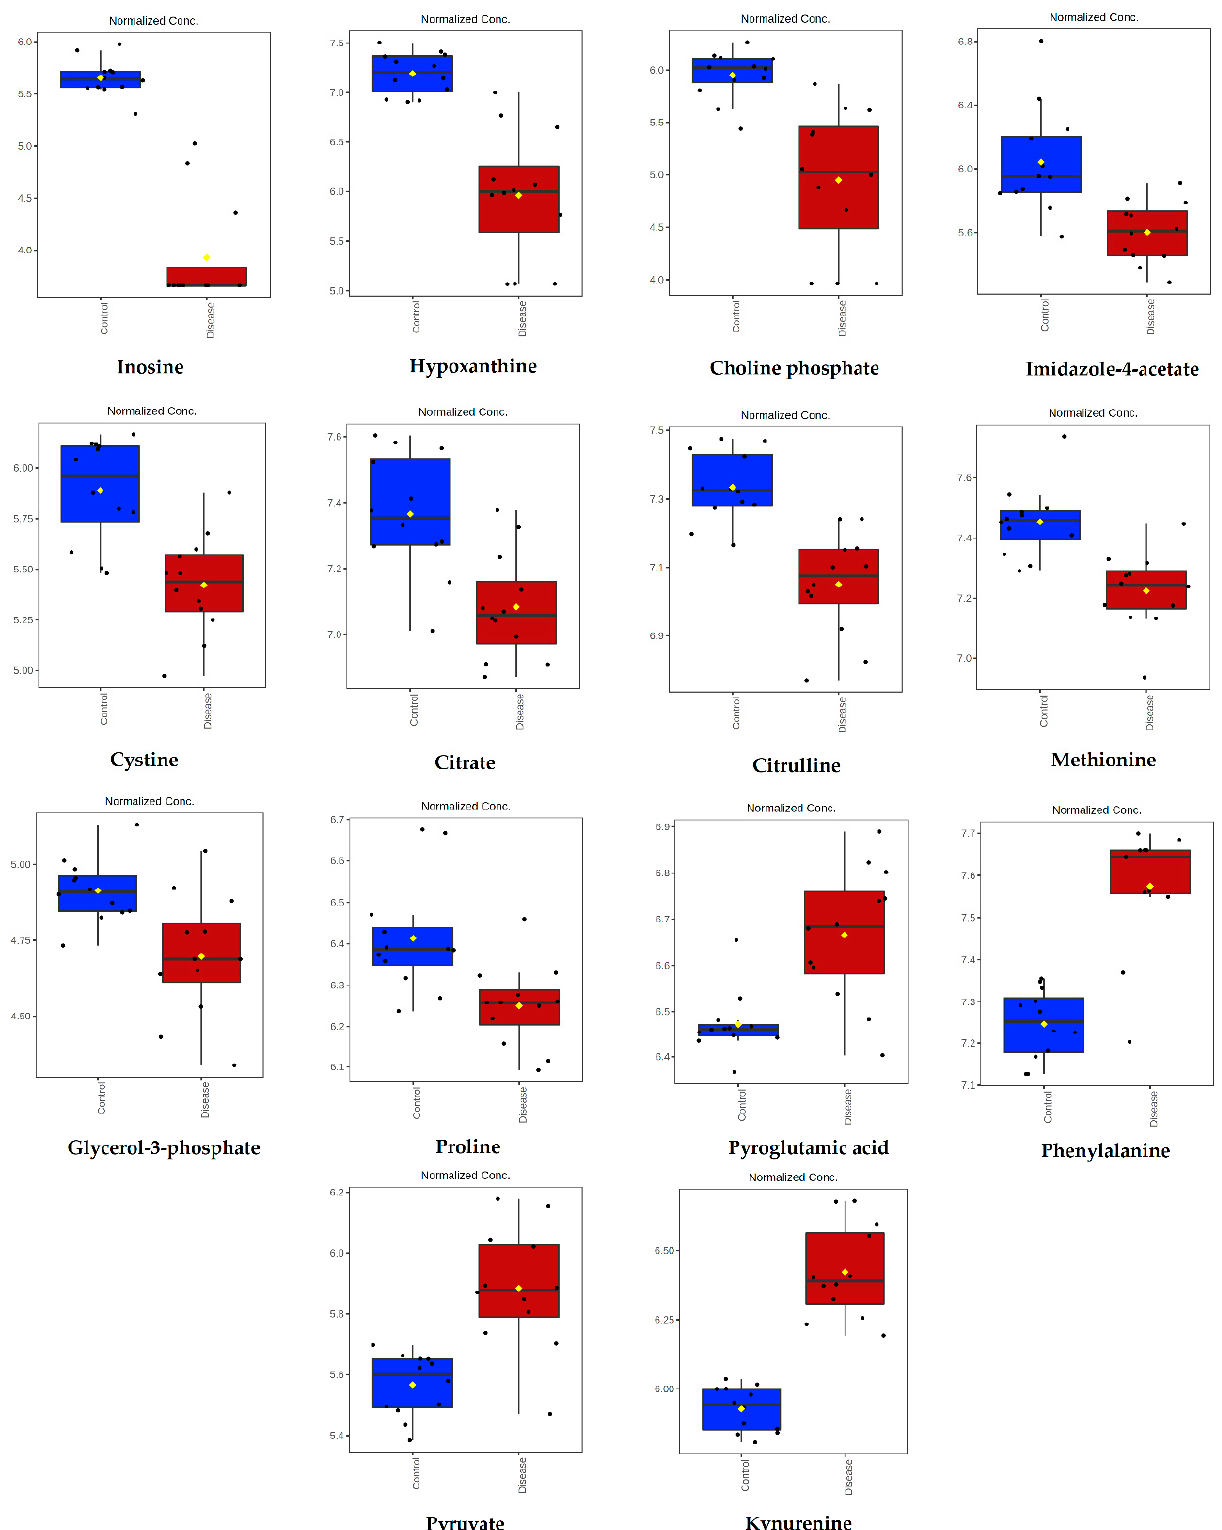
Figure 2. Intensity of metabolites significantly altered in dogs infected with B. canis and analyzed by the untargeted LC-MS metabolomics approach. Data are presented as box and whiskers plot (mean ± SD). All metabolites shown demonstrated a statistically significant difference between groups by t -test ( p < 0.05). Blue-control samples, red-disease samples.